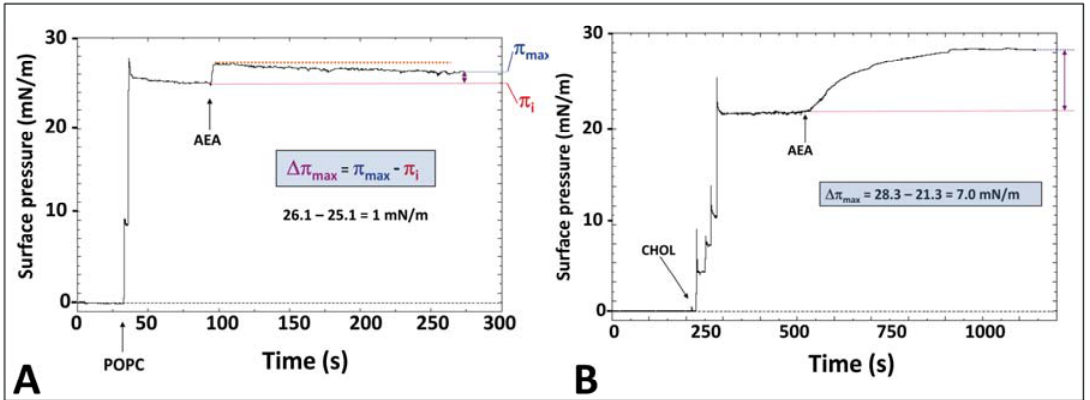
Figure 5. Anandamide interacts preferentially with cholesterol vs., phosphatidylcholine. ( A ) A monolayer of phosphatidylcholine (POPC) was prepared at the air–water interface at a stable value